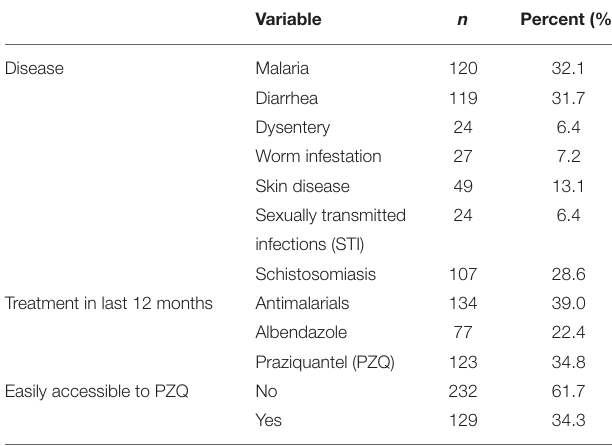
TABLE 7 | Proportion of all 376 participants who reported the diseases and treatment received in the preceding months before the study.